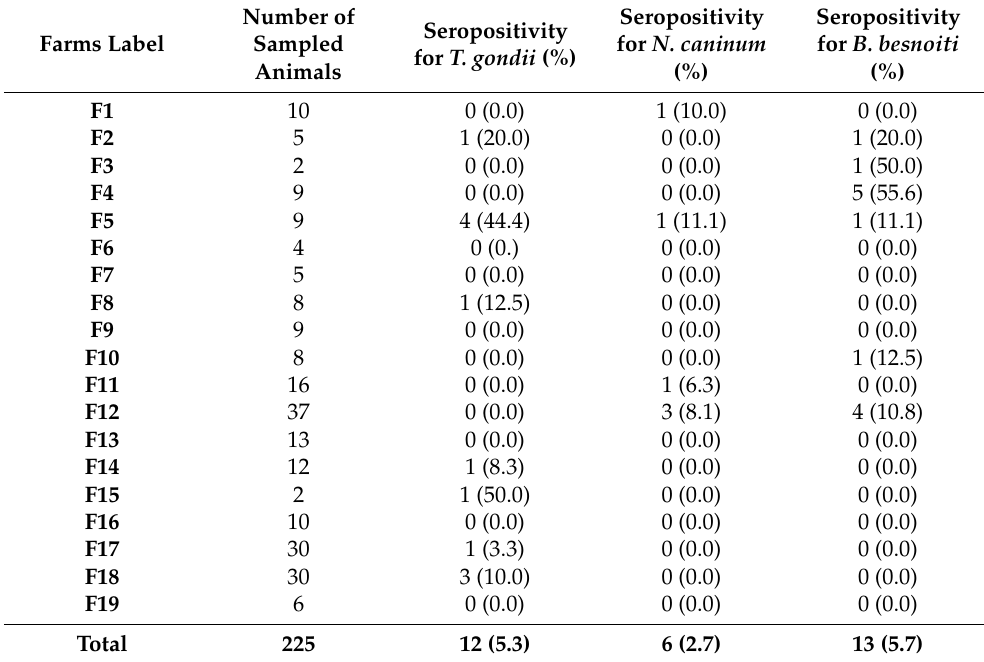
Table 2. Seroprevalence of T. gondii , N. caninum , and B. besnoiti antibodies in cattle (n = 225) sampled from 19 farms in Selangor, Malaysia.